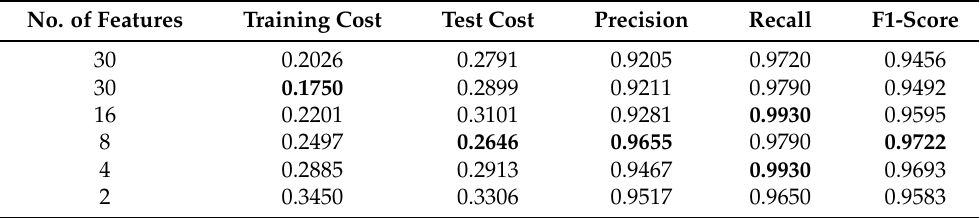
Table 3. Test set assessment outcomes for training performed on the UCI ML Breast Cancer Wisconsin (Diagnostic) Dataset training set. Corresponding training costs are also given. In each row, training was performed for 1500 iterations using the root mean squared propagation optimizer (step size of 0.01) and a batch size of 10. All values are given to four decimal places. The features in row 1 did not undergo PCA, while the features from the rest of the rows did. A random seed of ’1’ was used in each row, both for the train-test split and for all subsequent evaluations. The best value for each column is shown in